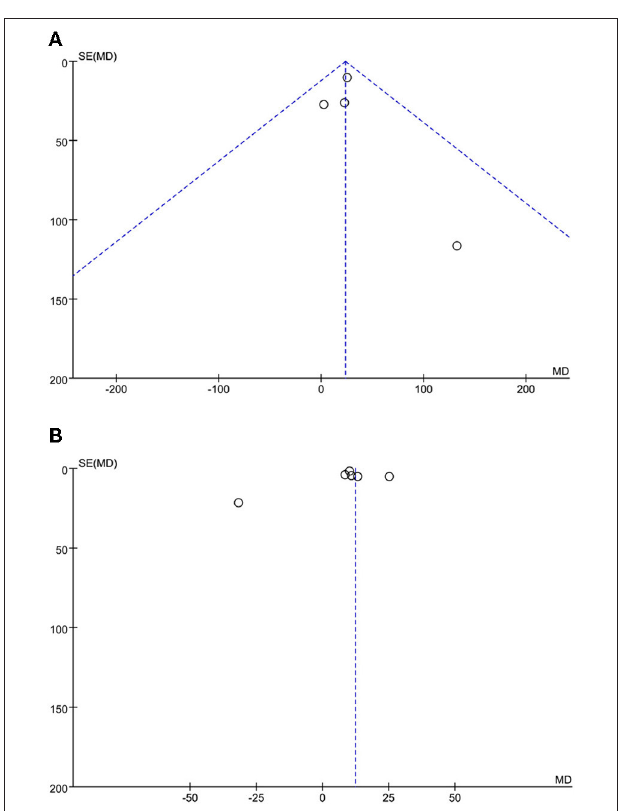
FIGURE 6 | (A) SO-to-FMC time funnel plot. (B) D2B time funnel plot.